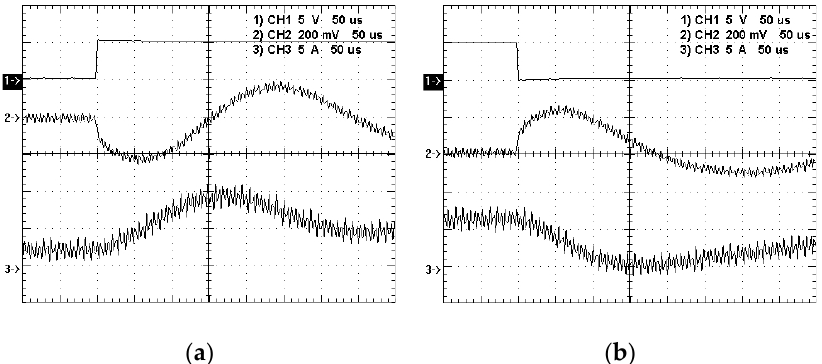
Figure 18. Zoom-in waveforms based on the proposed PWFM control strategy: (1) load enable; (2) AC